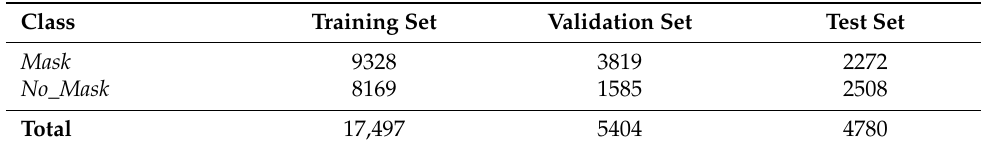
Table 3. Contents of training, validation, and test